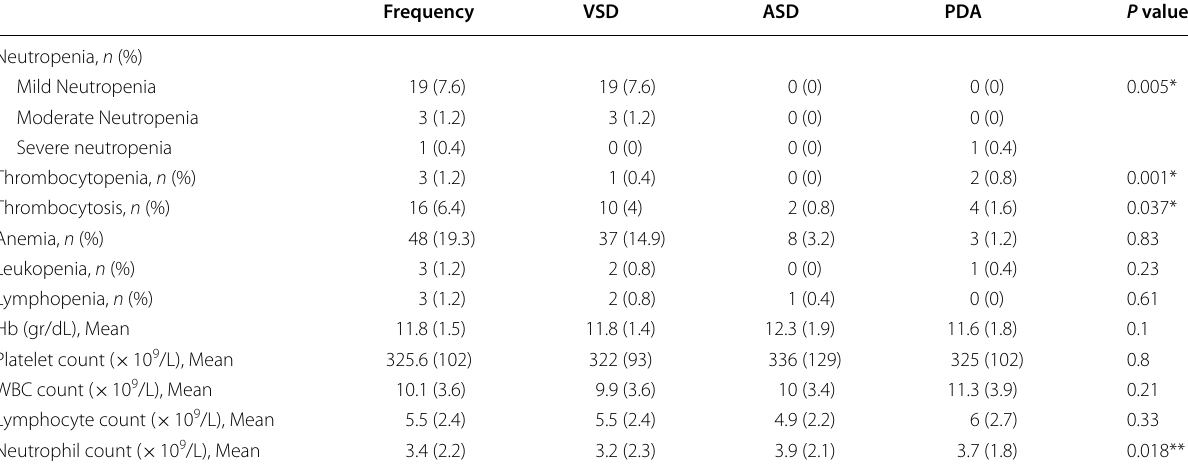
*Pearson Chi-Square asymptotic significance **Kruskal–Wallis test asymptotic